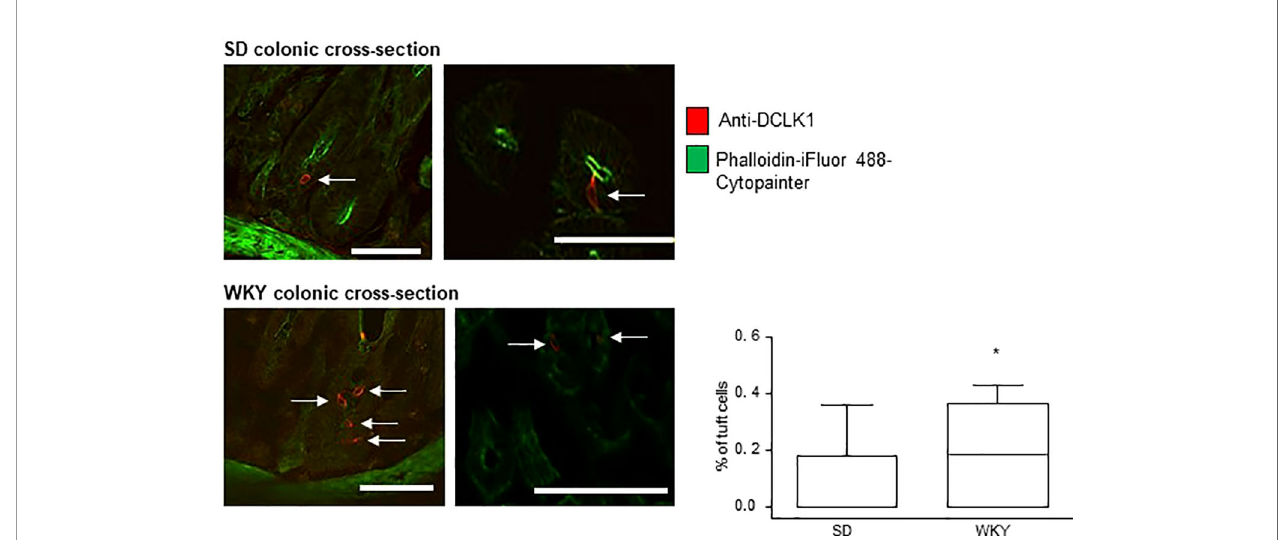
FIGURE 2 | Tuft cell density is increased in Wistar Kyoto (WKY) colons. The representative immuno fl uorescent images and box and whisker plots of pooled data show the density of DCLK1-labeled tuft cells as a percentage of the total DAPI-stained epithelial cells. Numbers of tuft cells are increased in stress-sensitive WKY rats, which have been validated as an animal model of IBS, as compared to Sprague Dawley control rats. * indicates p <0.05. Scalebar: 50